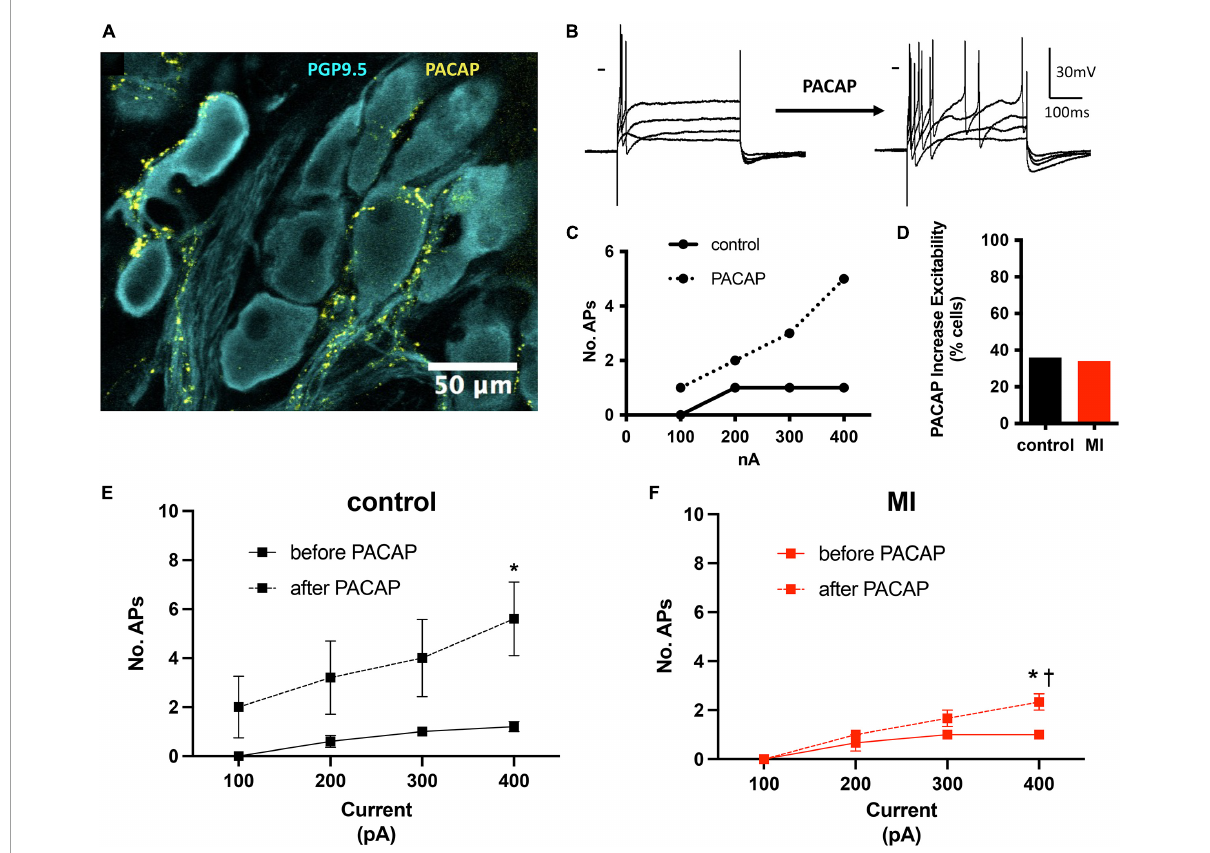
FIGURE4 PACAP increased excitability of control and MI ICNs. (A) PACAP-immunoreactivity was localized to pericellular varicosities surrounding some, but not all ICNs. (B) Extracellular application of PACAP (20 nM) increased membrane excitability as evident by a greater number of